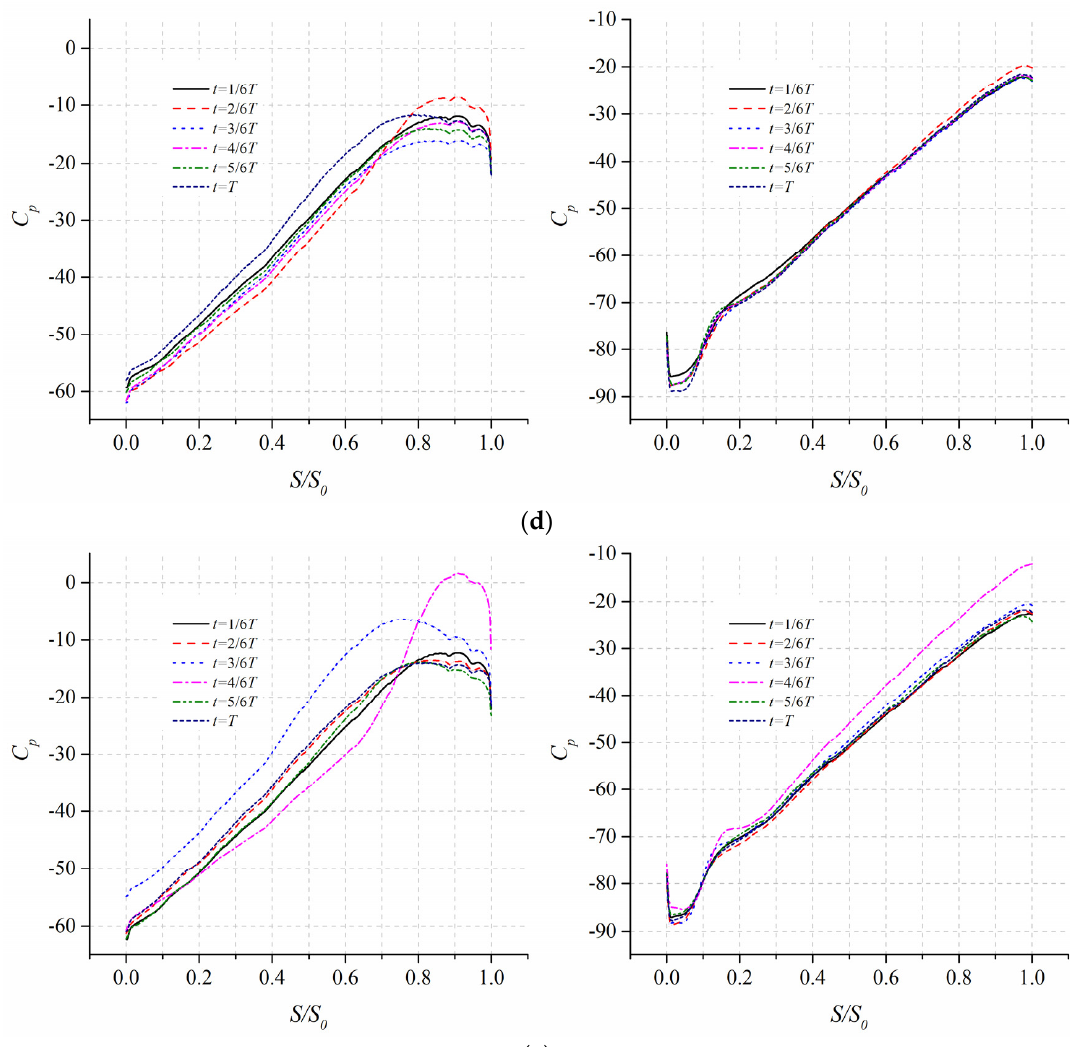
Figure 11. ( a – e ) Distribution of pressure coefficient at the mid-span (Z/b 2 = 0.5) of pressure surface (left) and suction surface (right) from inlet to outlet of the channel. The curves are plotted (from top to bottom) at U rot /U ref = − 0.5, − 0.3, 0.0, 0.3 and 0.5.